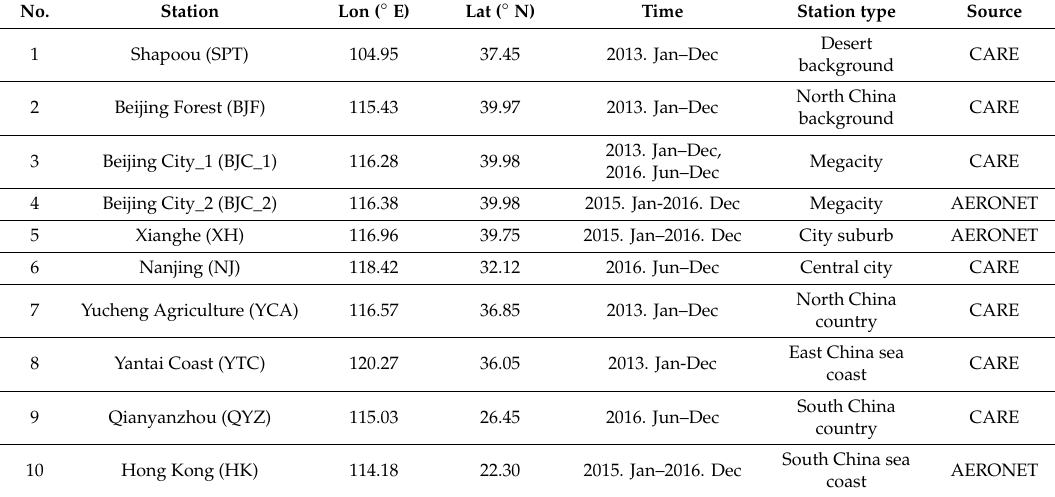
Table 1. Information about the ground-measurement